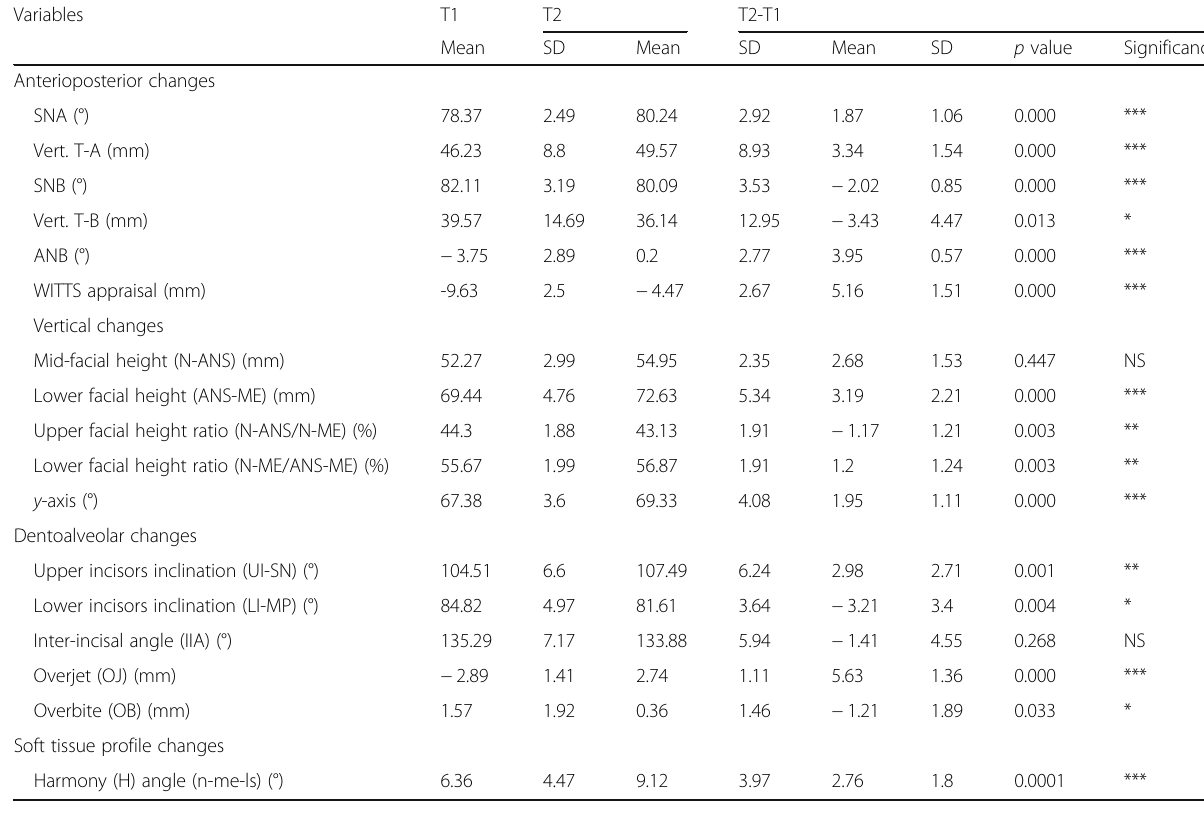
Table 2 Skeletal, dental and soft tissue changes from T1 to T2 Variables